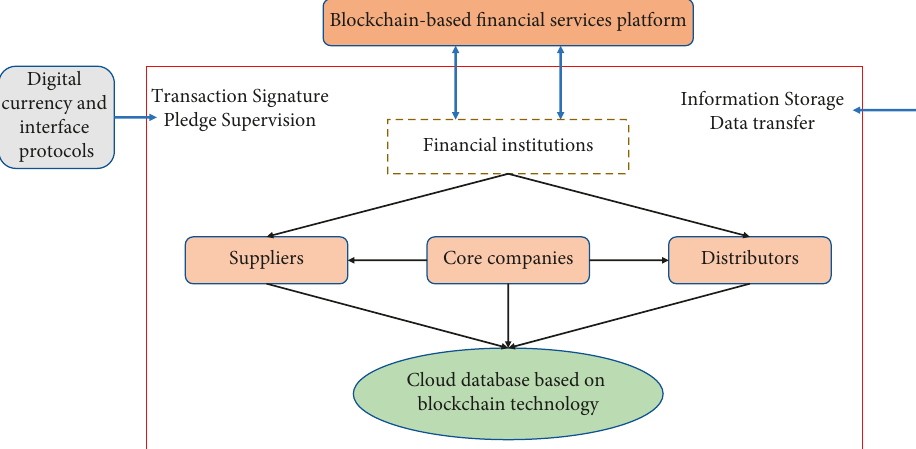
Figure 1: Blockchain platform financing